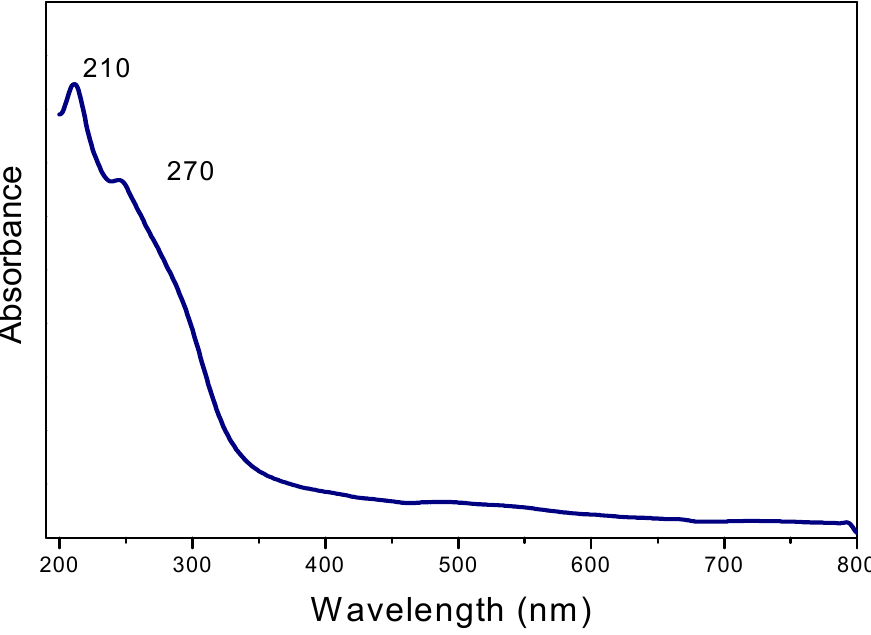
Figure 5. UV/visible spectrum of TiO 2 nanoparticles.